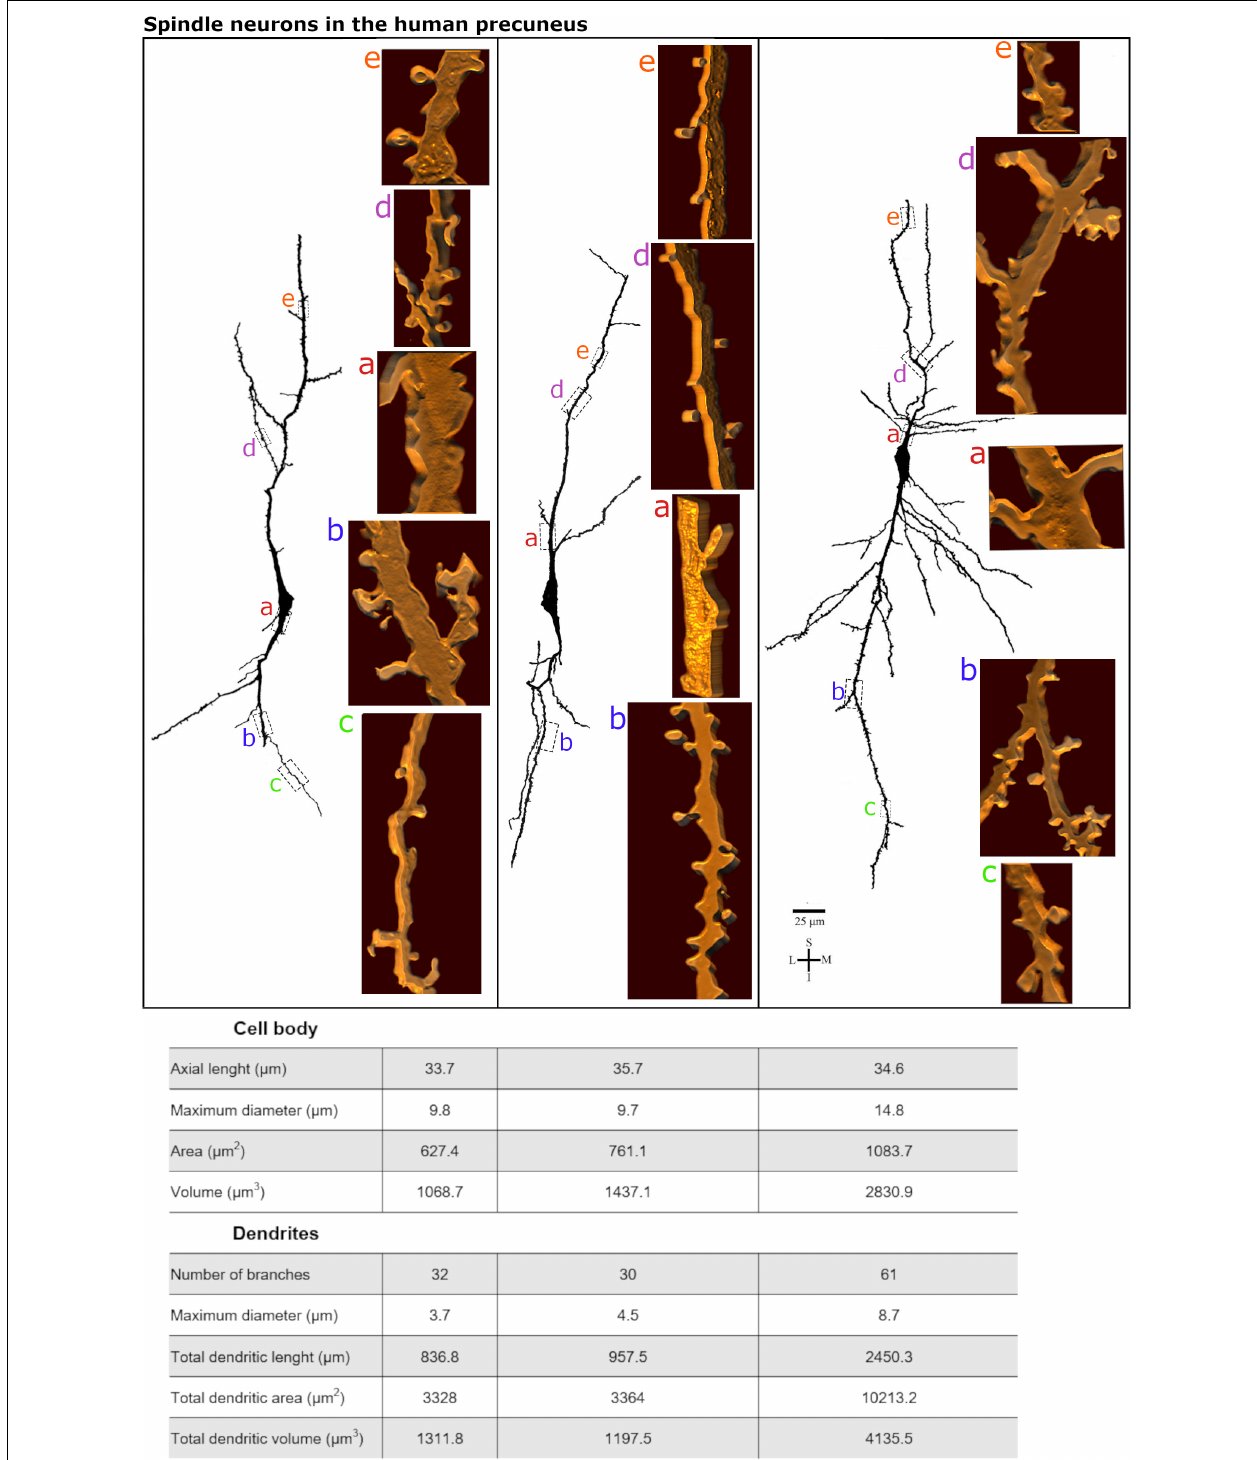
FIGURE 8 | (Top) Comparison of the morphological features for the dendrites of spindle-shaped neurons in the human precuneus cortex shown in Figures 5–7 . Compare the branching pattern of the spindle-shaped cell in the right with the others. Pleomorphic spines are shown from proximal to distal segments in these cells. Image adjustment of contrast made with Photoshop CS3 (Adobe Systems, Inc., United States). (Bottom) Quantitative data were obtained from these cells. Morphometrical data refer to the cell body parameters (note the similar axial length) and features of both ascending and descending dendrites (note the values for the neuron in the right compared to the